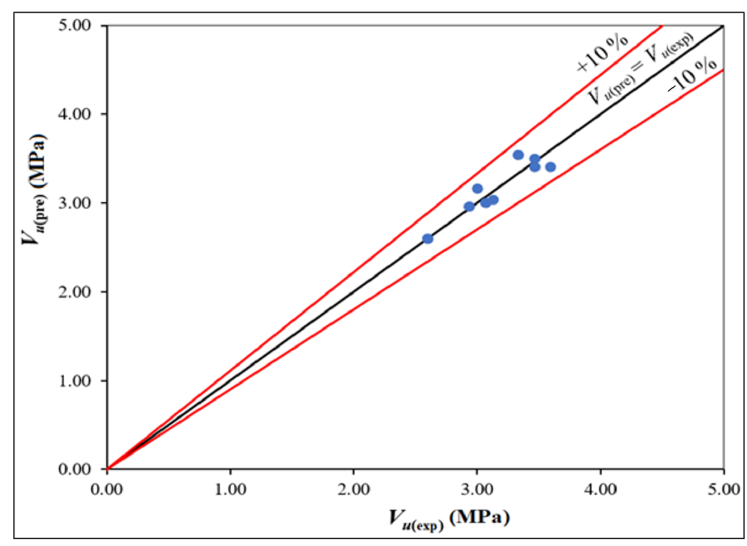
Figure 7. Comparison of experimental and predicted values of shear strength.